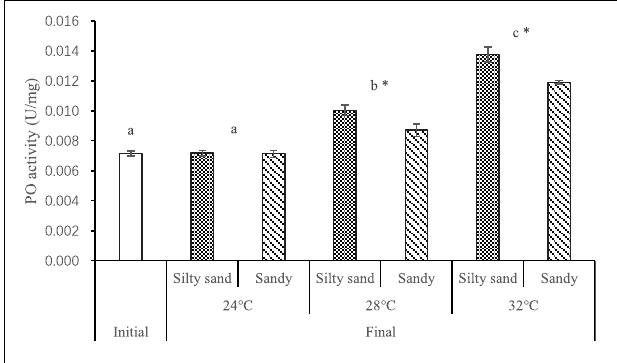
FIGURE 5 | The activity of PO in Manila clam hepatopancreas at different temperatures and in different sediment types. The different letters indicate significant difference of PO at different temperatures. ∗ indicates significant difference of the activity of PO in manila clam in different sediment types under the same temperature